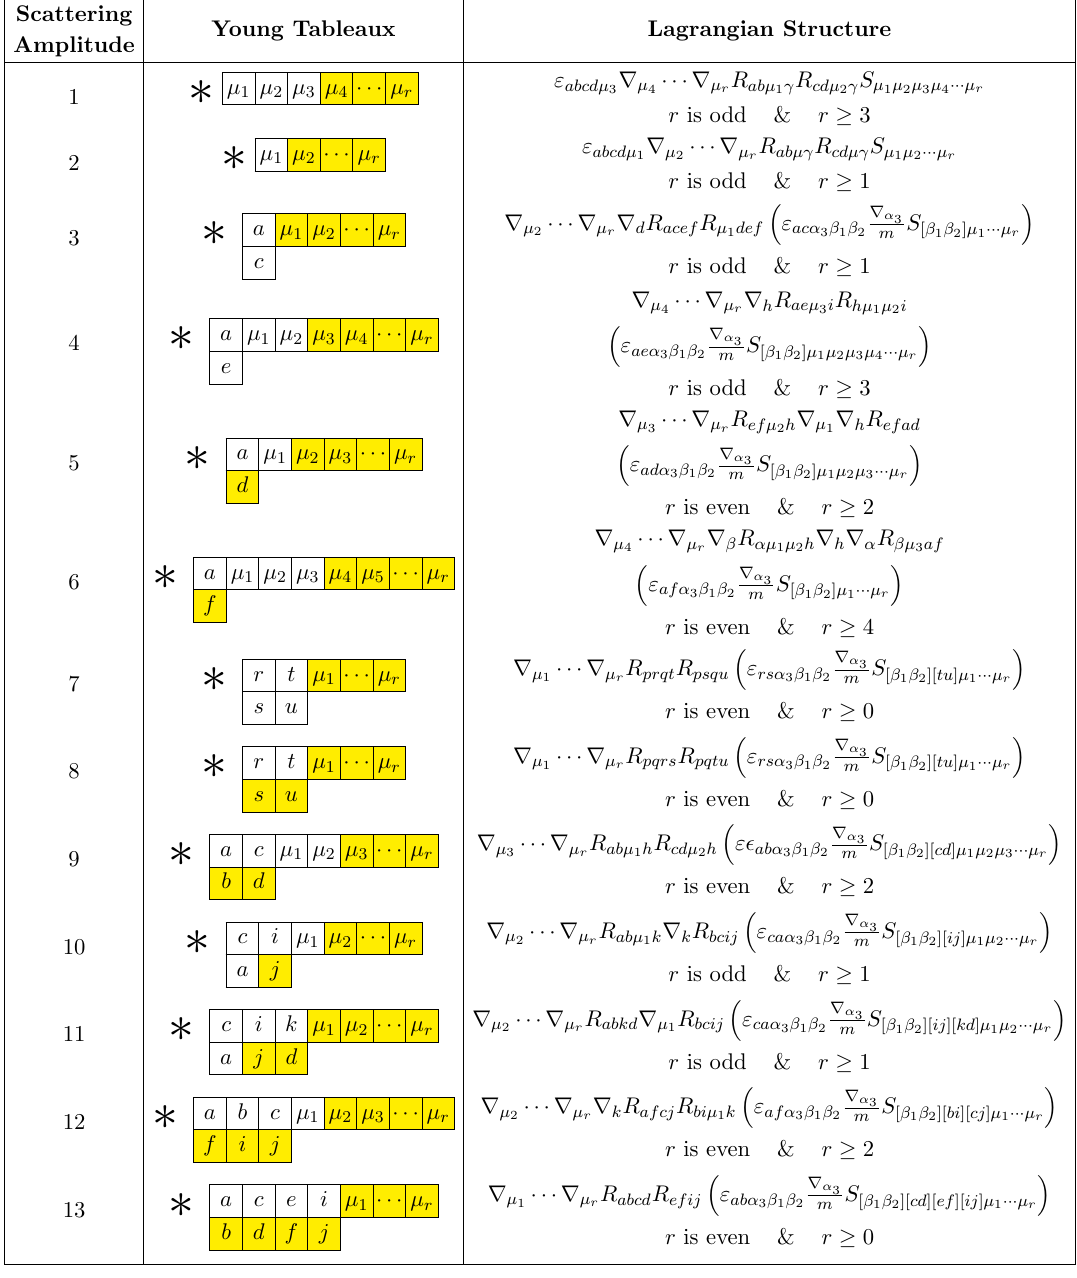
Table 9. Gravitons , D = 5. The meaning of the symbol The antisymmetric spin zero state is constructed with the aid of an SO(2) " tensor.